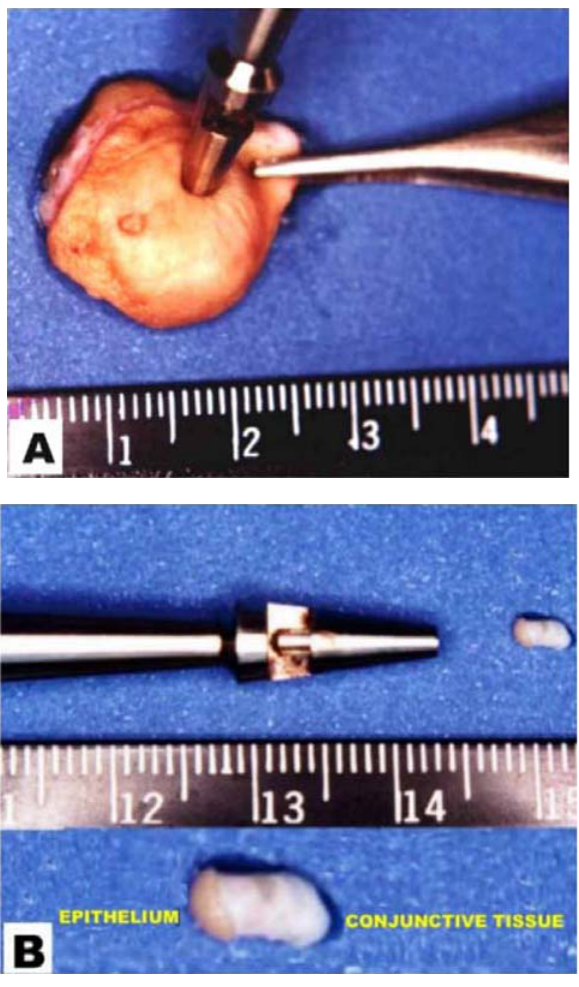
FIGURE 3 - Method for obtaining keloid fragments. A) With a 2 mm punch, pouch fragments are collected from the epithelized surface, including conjunctive tissue. B) Aspect of the obtained keloid fragment; on the detail we may see both epithelium and conjunctive